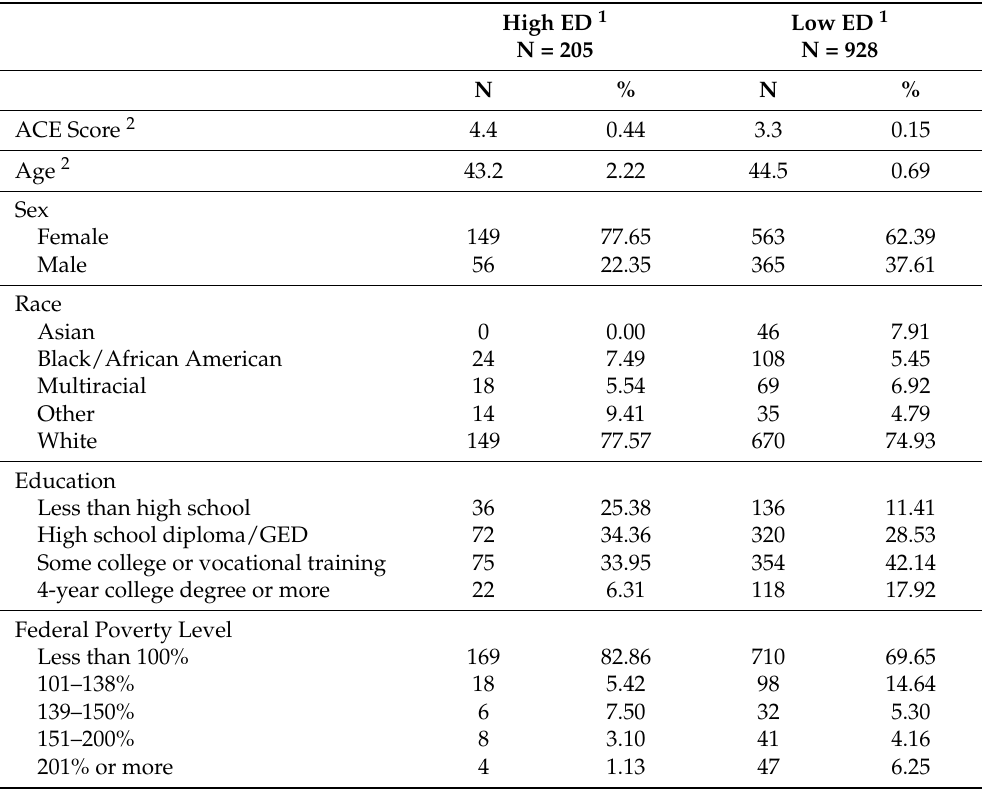
Table 1. Socioeconomic characteristics of the study population of Medicaid-enrolled adults in the Portland, OR metropolitan area, stratified by high and low ED